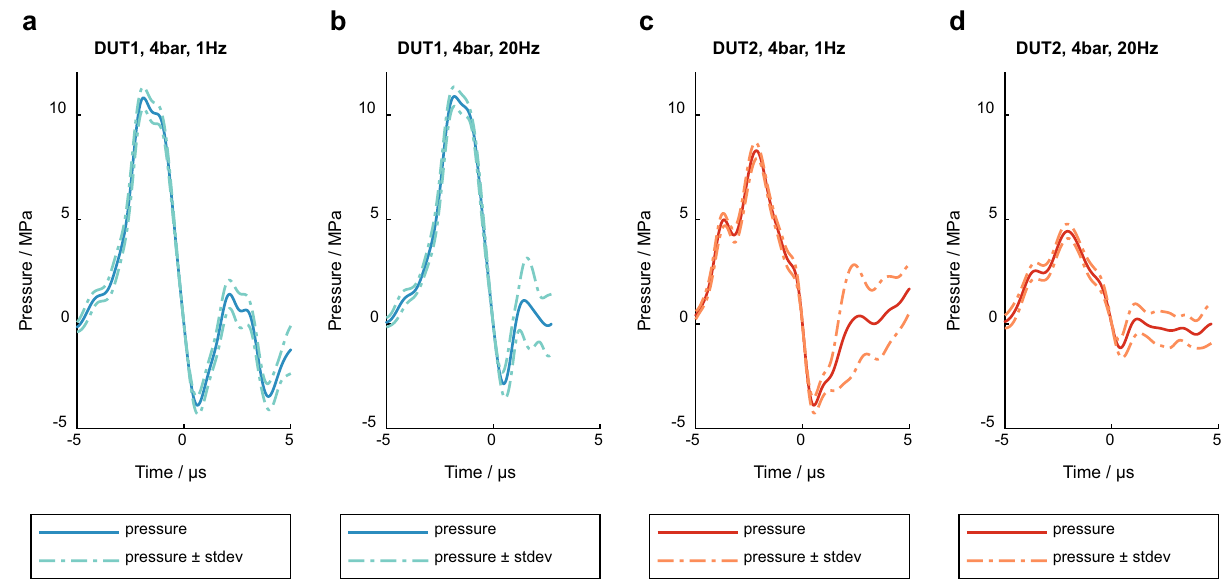
Figure 3. Examples of mean pressure curves and standard deviation of both devices at 4 bar and different PRR. ( a ) DUT1, 1 Hz. ( b ) DUT1, 20 Hz. ( c ) DUT2, 1 Hz. ( d ) DUT2, 20